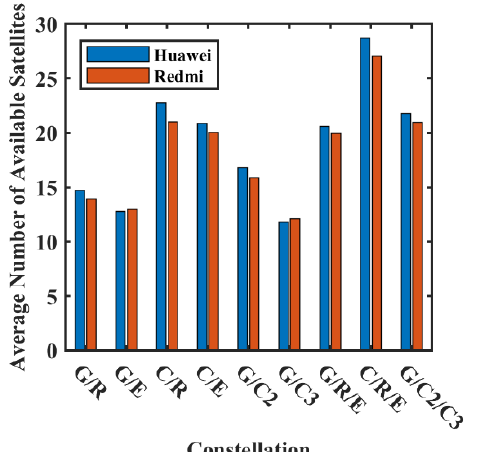
Figure 15. The average number of available satellites for dual/triple-constellation in velocity determination.